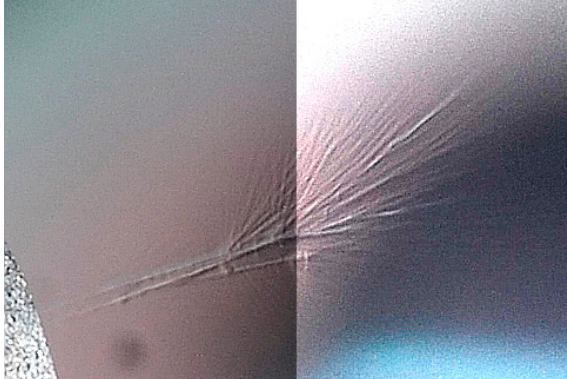
Figure 17. Images of partial discharges in SF 6 at 0.4 MPa, negative polarity at a surface field of 375 kV/cm. The picture is edited with different brightness on the two halves to better show the structures of the partial discharge.